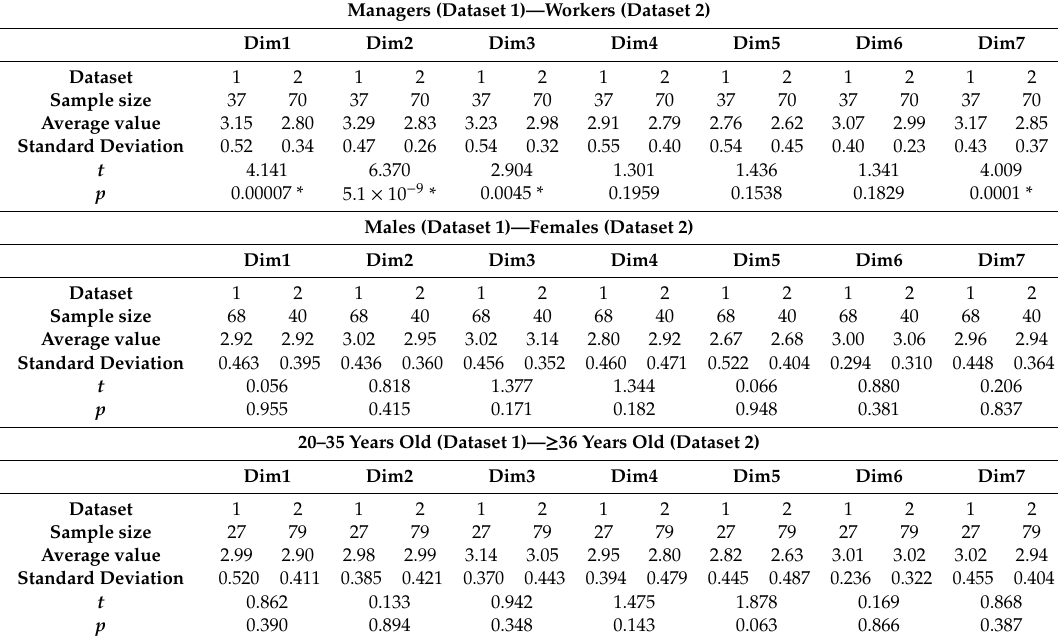
Table 5. Results of the t -test analyses, where t indicates the t -test output, while p indicates the level of significance (* indicates p <